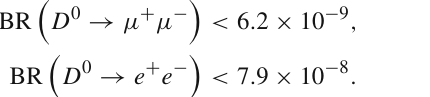
(cid:2) LQ Wilson coefficients i